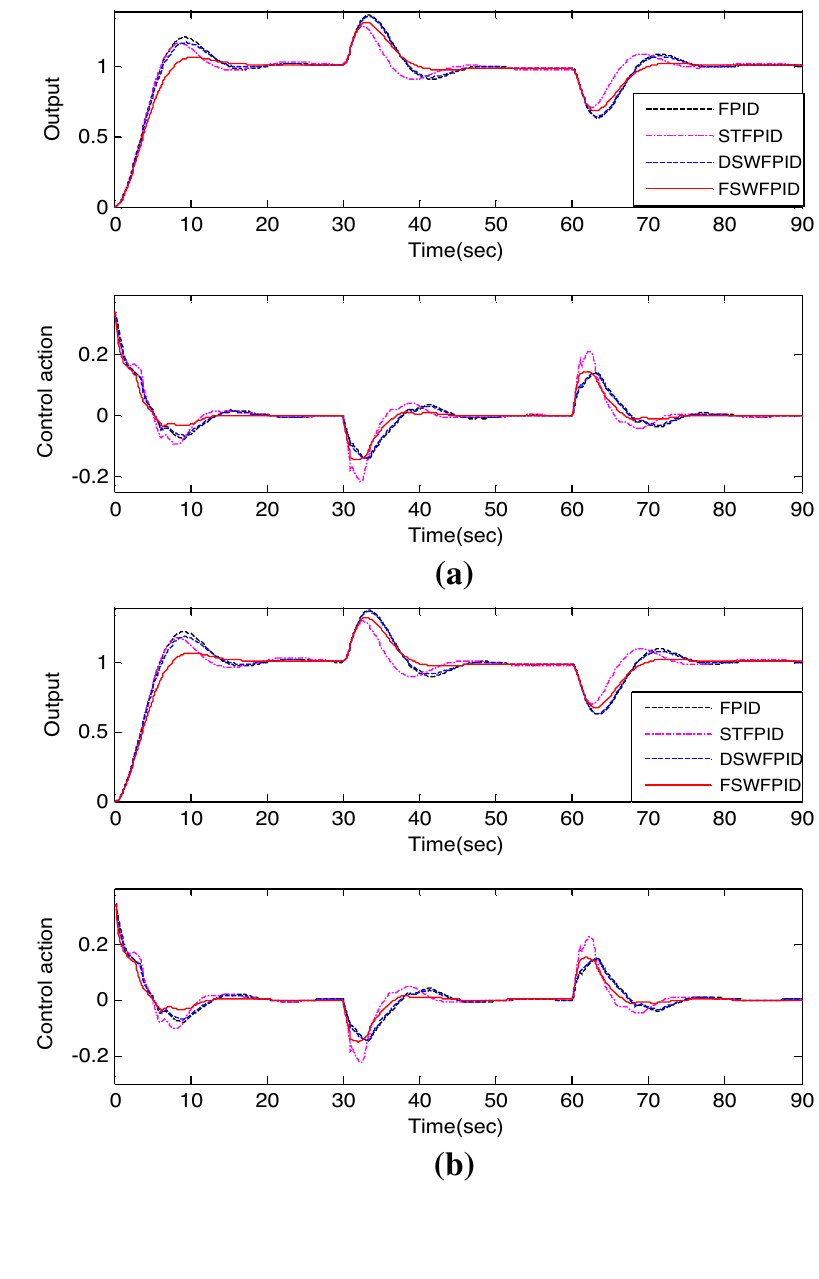
Fig. 21 Responses and control actions for Model V using 25 rules during set point response and with load variation for a L = 0.2 s, b L = 0.3